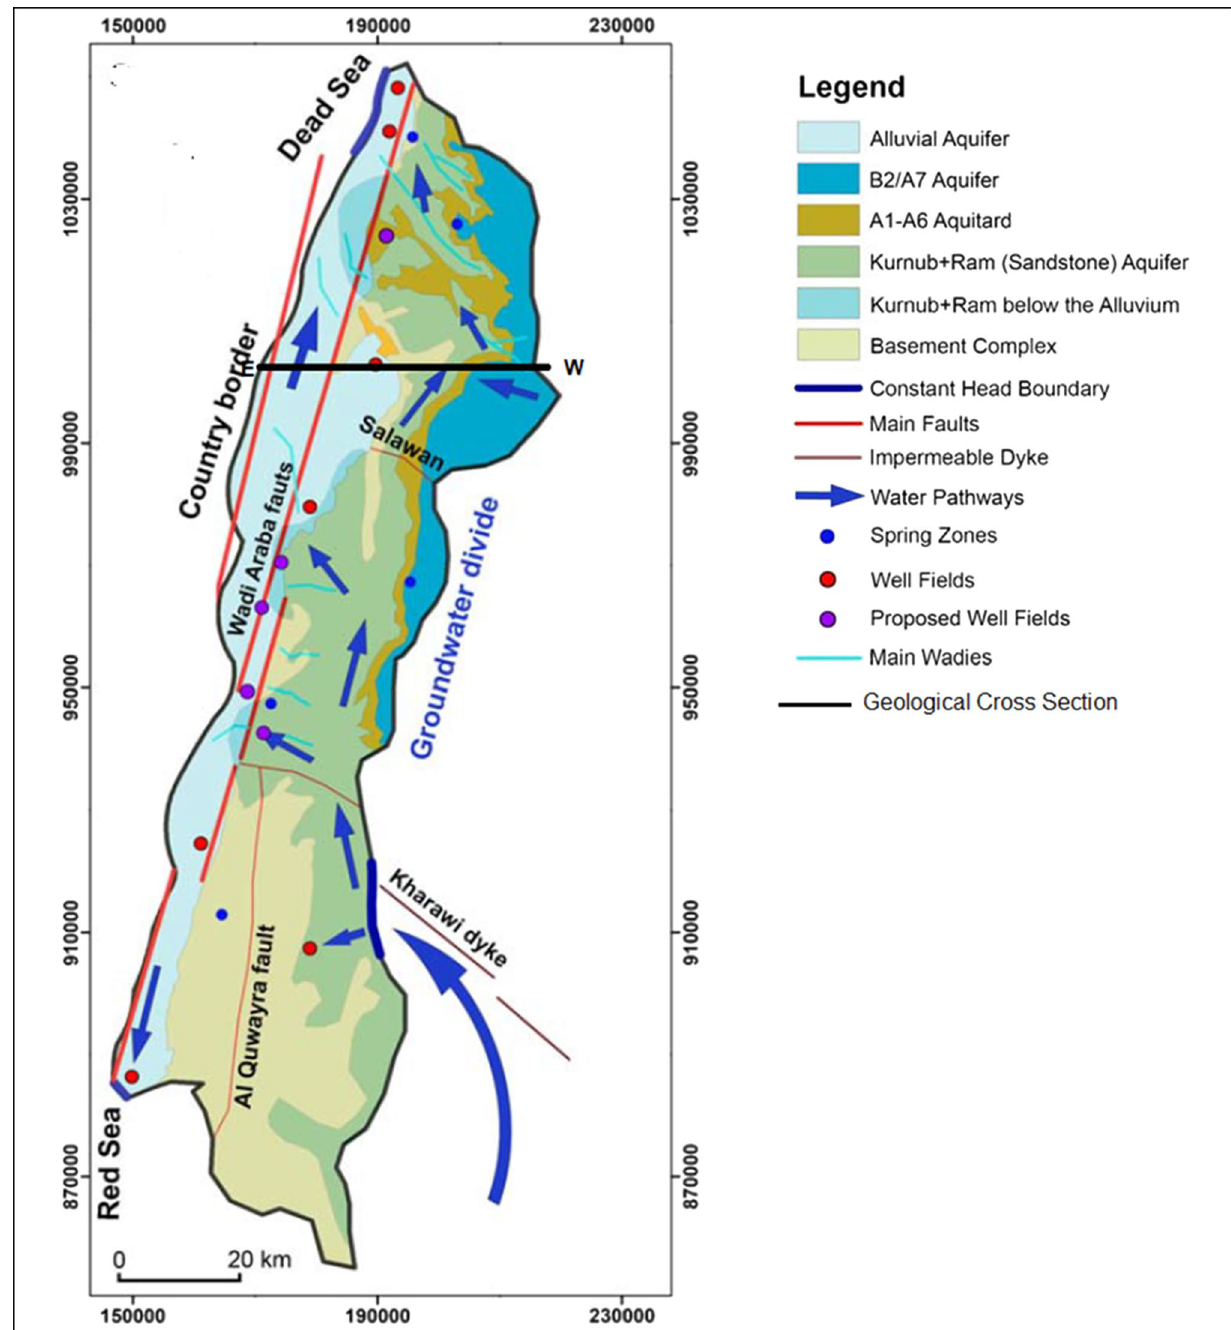
Fig. 2 Hydrogeological rock units of the Wadi Araba Basin (Radulovic et al.